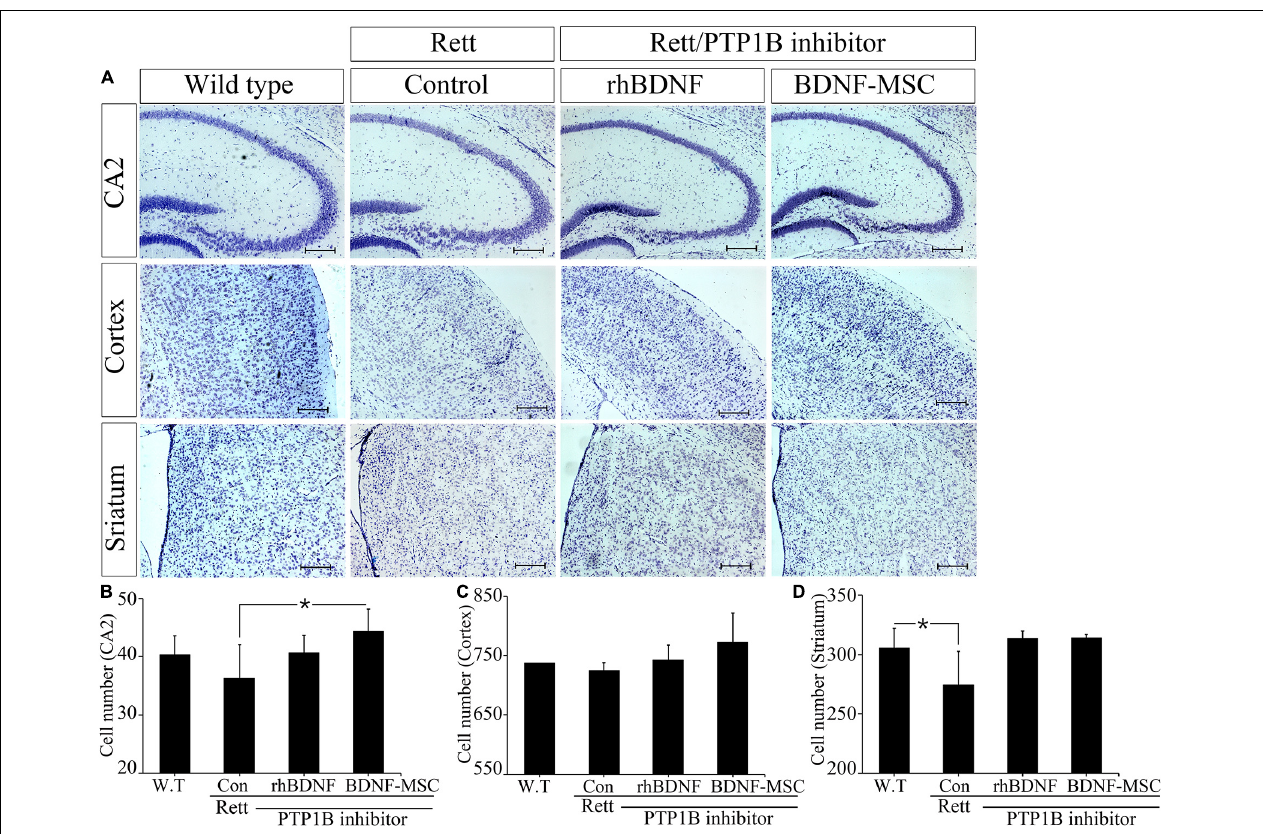
FIGURE 5 | Improved neurogenesis following BDNF-MSC treatment. (A) The samples from wild type, MECP2 knockout (Control-Rett), MECP2 knockout co-treated with BDNF/PTP1b inhibitor or BDNF-MSC/PTP1b groups were stained with cresyl violet. The cell numbers for each group were counted in three different areas of the brain: (B) CA2 of the hippocampus, (C) cortex, and (D) striatum. Cell numbers were counted using the ImageJ software and they are presented in the graphs. * p <